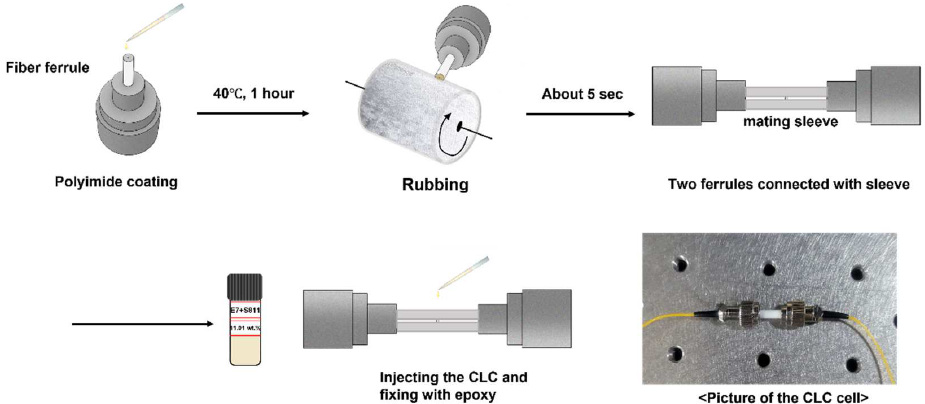
Figure 2. Fabrication process of the CLC cell.